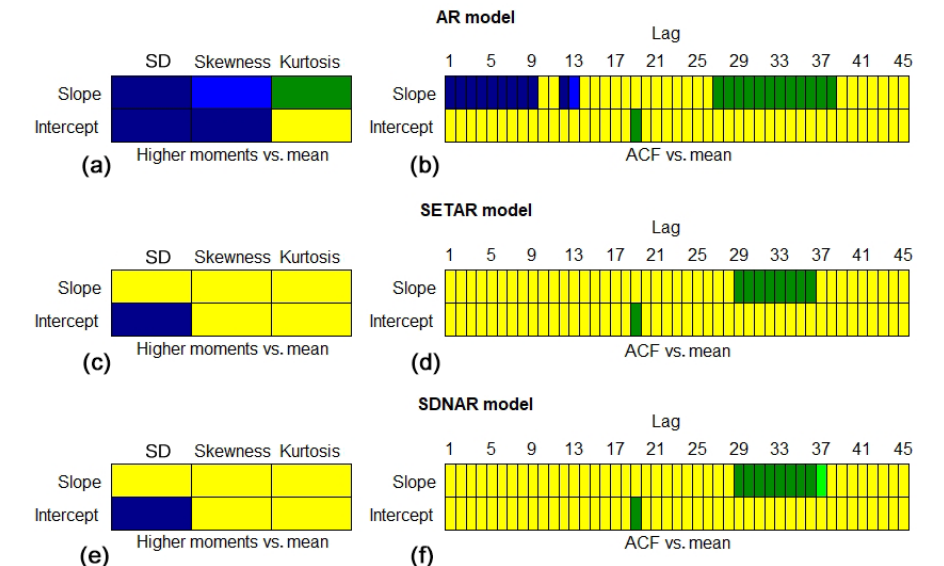
Figure 5. Plot of the ability of the AR (a–b) , SETAR (c–d) and SDNAR (e–f) models to reproduce the higher moments and sample ACF of the daily NAO winter index. The results are based on simulations of 142000 winters, where the November data preceding each of the 71 winters in the testing data are used as initial values for simulations of 2000 winters. For the 142000 winters, we have calculated the first four sample moments and sample ACF for lags 1–45 and performed linear regressions using ordinary least squares for all variables, with the sample mean as the explaining variable. Panels (a, c and e) show results for the regression intercept and slope for standard deviation, skewness and excess kurtosis, and panels (b, d and f) show the results for sample ACF for lags 1–45. The colours in the plots indicate the relation between the 95% confidence intervals for the intercept or slope, based on simulations and the 95% confidence interval of the corresponding regression parameter for the testing data. A confidence interval based on simulations can, in relation to the corresponding one based on observations, be strictly smaller (dark green), partly overlap but contain values smaller than the minimum of the interval based on observations (light green), overlap entirely (yellow), partly overlap but contain values larger than the maximum of the interval based on observations (light blue) or be strictly larger (dark blue), respectively.